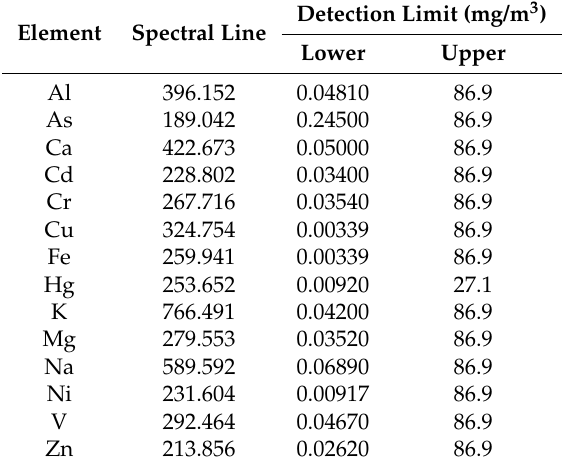
Table 4. Emissions spectra (wavelengths) and detection limits for the elements assessed via ICP.